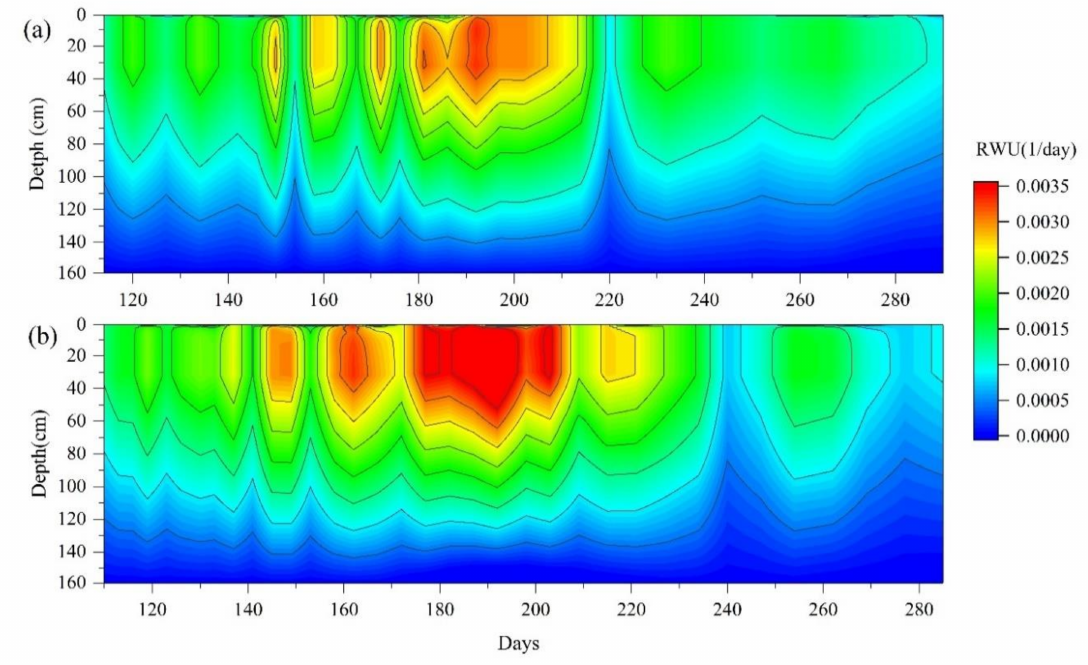
Figure 5. The dynamics of the RWU rate in apples at different soil depths during 2016 ( a ) and 2017 ( b ). Compared with the results by the isotopic method, in the October 9 of 2017 (Figure 5b), we did not find the increasing rate in the 20–40 cm layer than that of 0–20 cm. In this study, the root